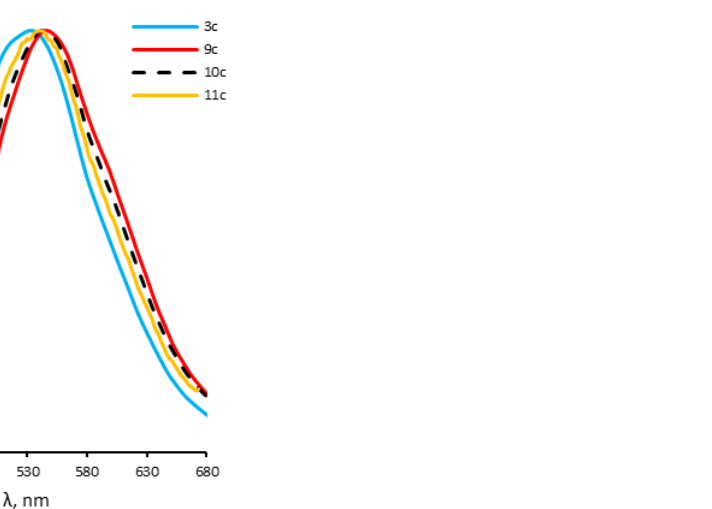
Figure 5. UV-VIS and normalized fluorescence spectra in acetonitrile: ( a ) series of ethyl coumarin- 3-carboxylates compounds 9a–e , 12b ; ( b ) series of methyl coumarin-3-carboxylates compounds 10a–